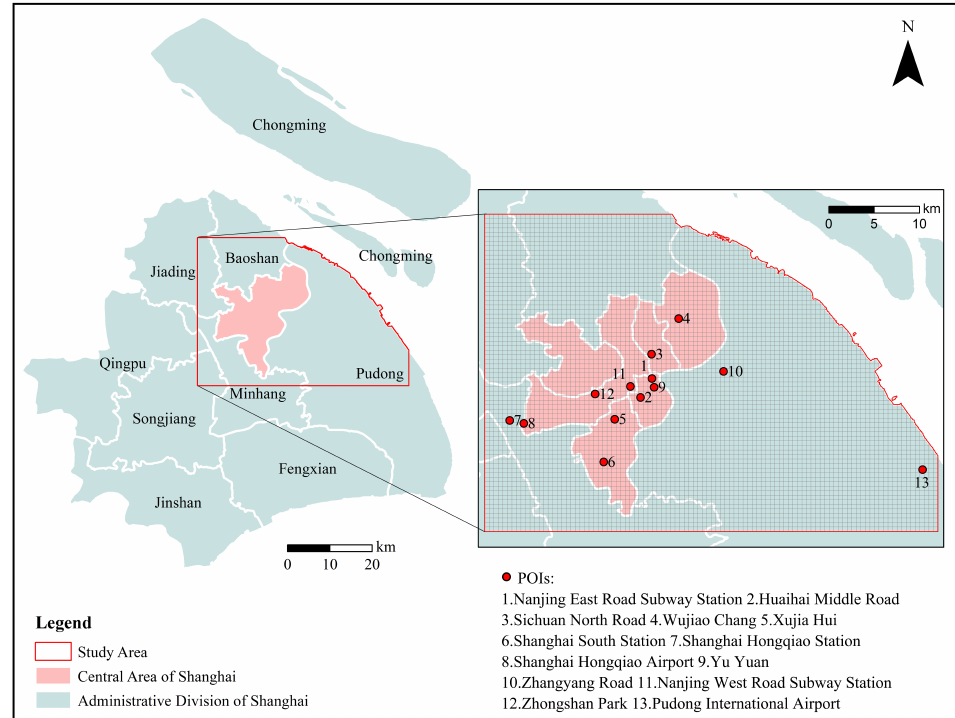
Figure 2. Study area (Shanghai,